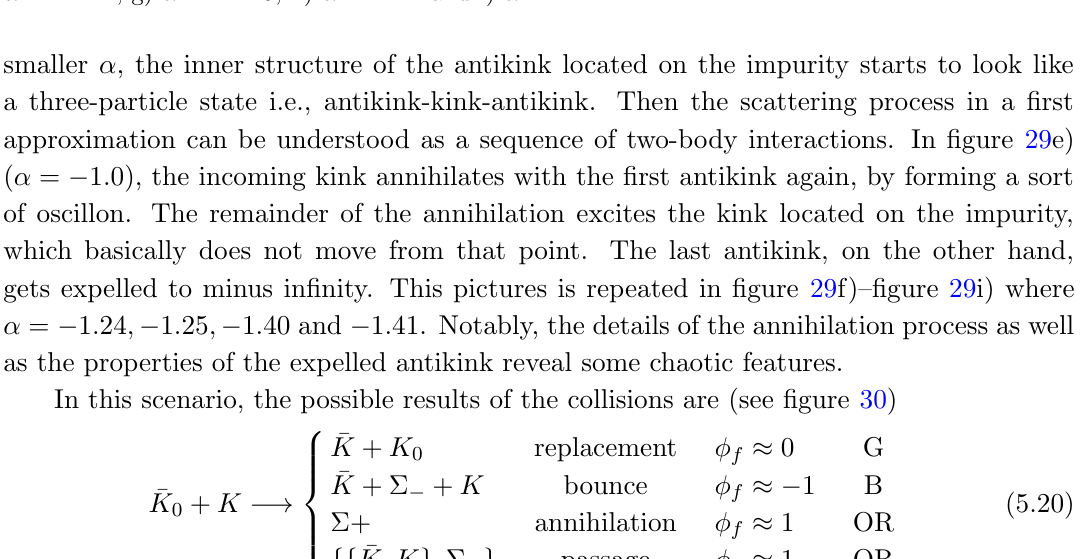
Figure 29 . Di(cid:11)erent scenarios of kink-(antikink-on-impurity) ( K + (cid:22) K 0 ) collisions for the velocity v = 0 : 2. The parameter values are a) (cid:11) = 1, b) (cid:11) = 0 : 5, c) (cid:11) = (cid:0) 0 : 1, d) (cid:11) = (cid:0) 0 : 3, e) (cid:11) = (cid:0) 1, f) (cid:11) = (cid:0) 1 : 24, g) (cid:11) = (cid:0) 1 : 25, h) (cid:11) = (cid:0) 1 : 4 and i) (cid:11) = (cid:0) 1 :